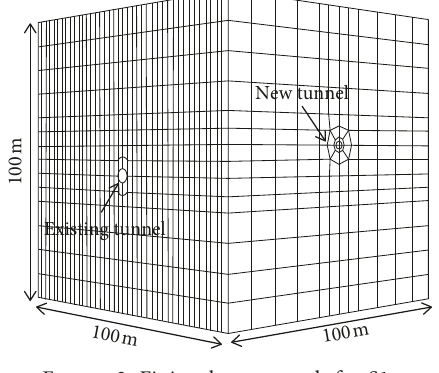
Figure 3: Finite element mesh for S1. Table 1: Numerical analysis program.